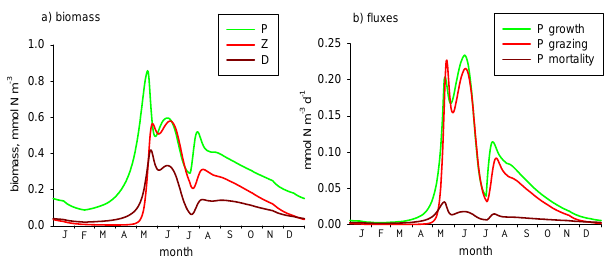
Figure 11. Simulation for station BIOTRANS after parameter tun- ing (see text): (a) chlorophyll, (b) nitrate.